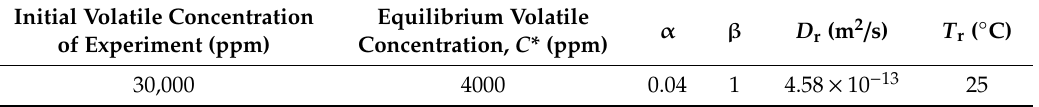
Table 2. Parameters used to calculate the di ff usion coe ffi